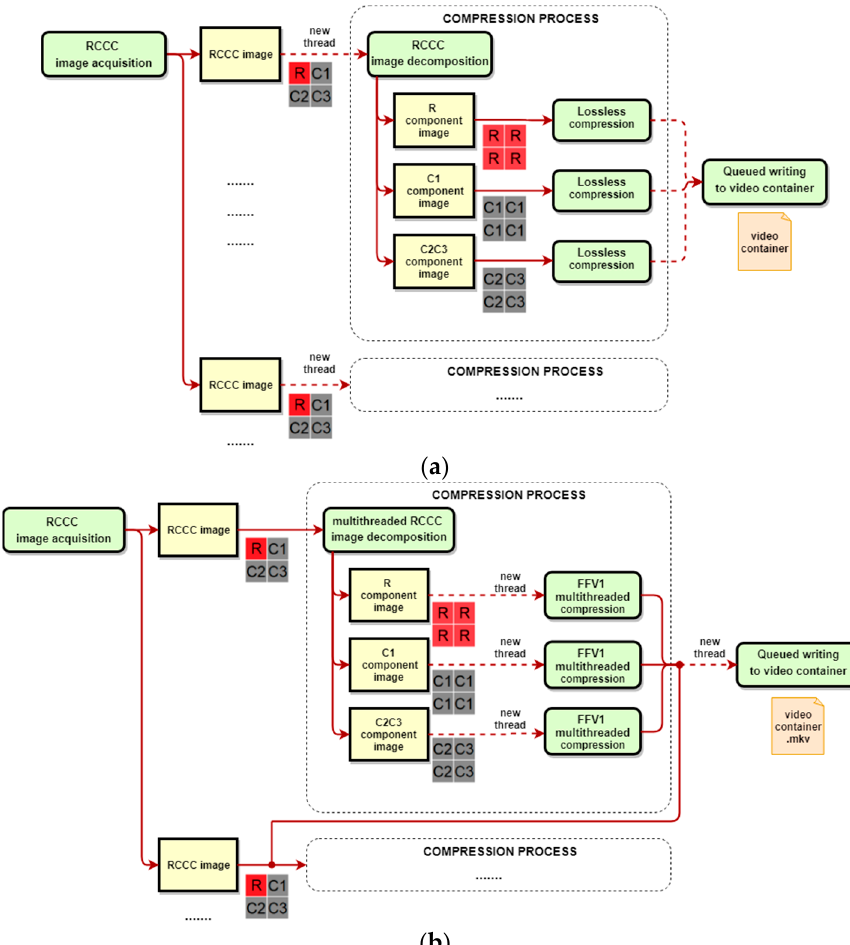
Figure 7. RCCC lossless compression procedures with FFV1 codec for separated R, C1 and joined C2 and C3 components in: ( a ) intra-frame mode, ( b ) inter-frame mode.